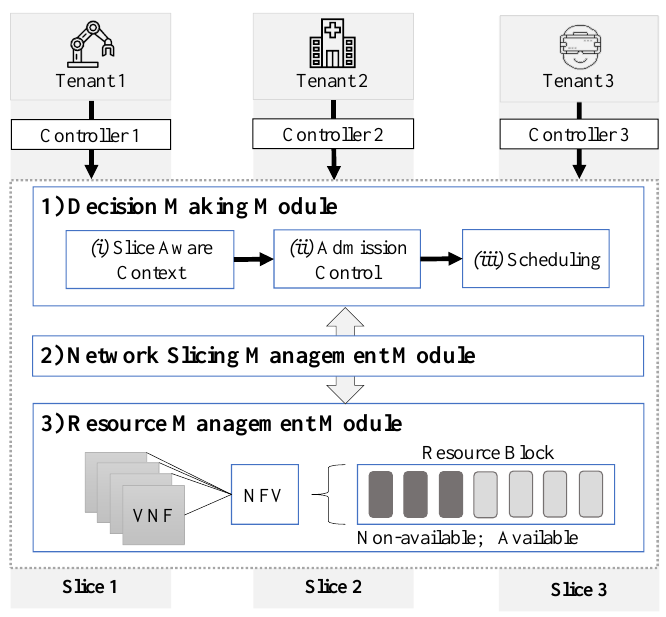
Figure 3. PRIMUS